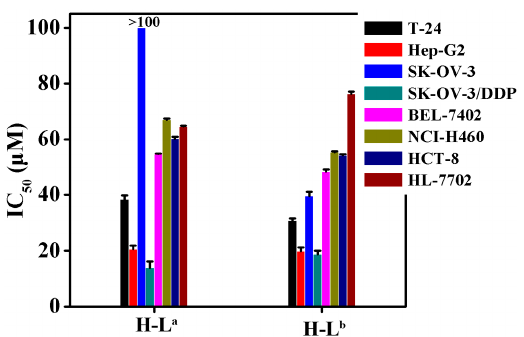
Figure 3. IC 50 values (µM) of H-L a and H-L b for selected cells (T-24, HCT-8, Hep-G2, SK-OV-3/DDP, BEL-7402, HL-7702, SK-OV-3 and NCI-H460 human cell lines).